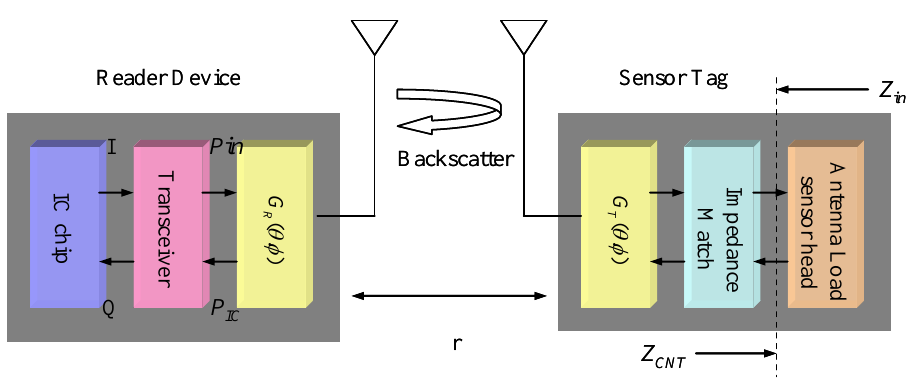
Figure 1. Principle of RFID-based methane